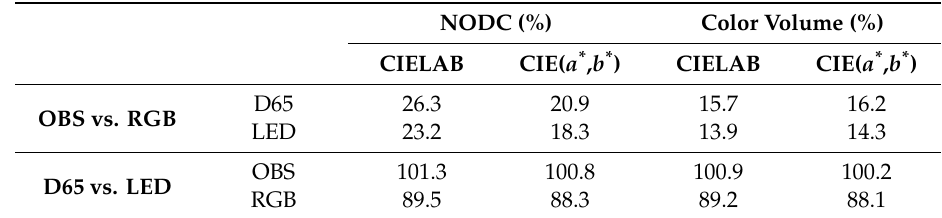
Table 2. Percentage variations of the data represented in the first two columns of Table 1, considering all the images analyzed, combining the data from paintings and natural scenes. NODC (%) Color Volume (%) CIELAB CIE( a * , b * ) CIELAB CIE( a * , b * ) OBS vs.